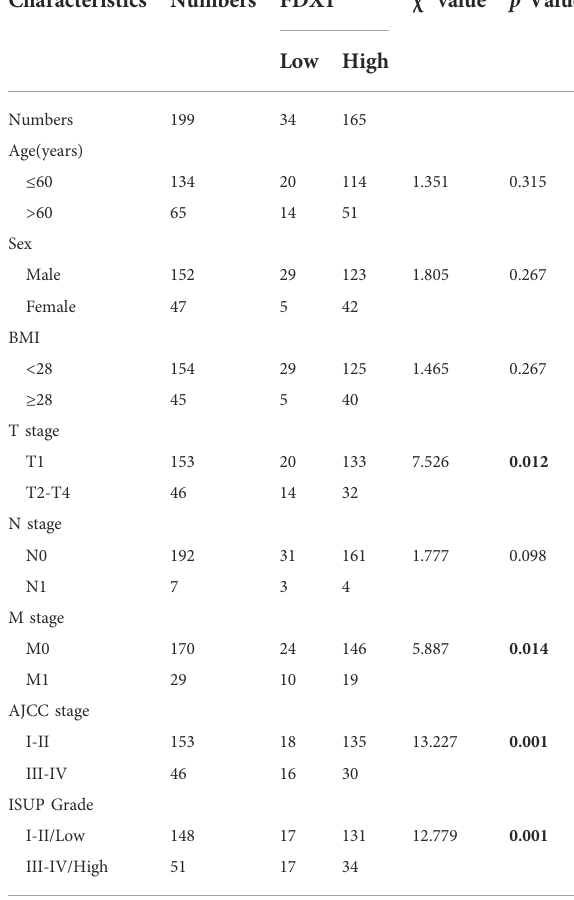
TABLE 1 Correlation between FDX1 expression and clinical characteristics in 199 patients with